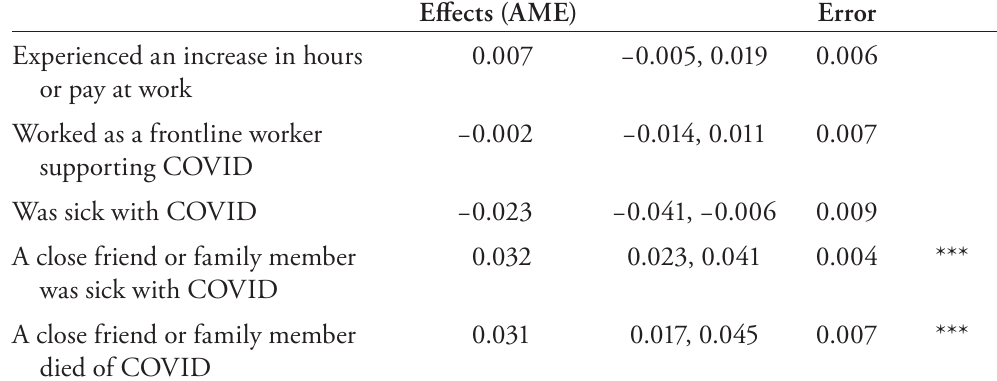
Table 3. Results of the Logistic Regression for Generalized Anxiety Disorder (GAD) ( continued